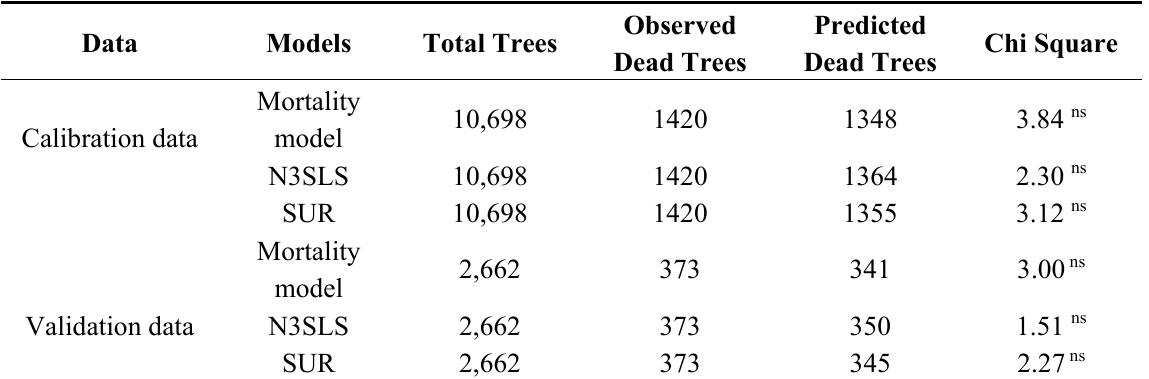
Figure 9. Observed and predicted mortality trees for simultaneous equations using N3SLS and SUR and separate mortality model. Table 8. Test in predicting and observing the mortality probability for calibration and validation data